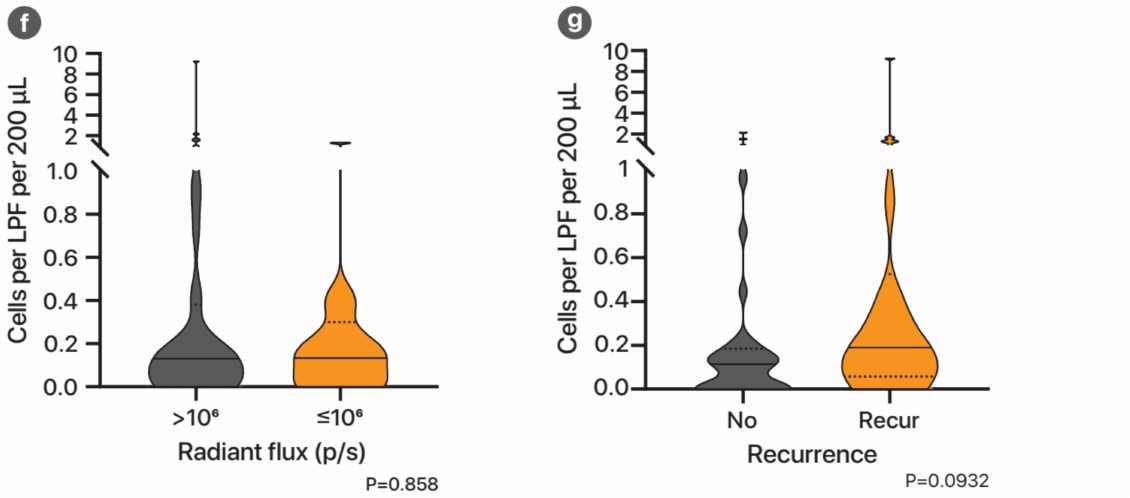
Figure 4. Effect of tumour burden and treatments on circulating tumour cells and circulating pancreatic stellate cells. ( a ) Violin plot of circulating rare cell numbers. This includes all mice, regardless of treatment group allocation. Solid transverse line represents the median. Dotted lines represent the first and third quartiles. (b ) CTC counts in animals with and without recurrence, as defined by the combination criteria. *** p < 0.001. ( c ) Receiver operator characteristic curve describing the performance of CTC counts as a test to determine recurrent disease. Different points in the curve represent different cut-offs for CTC counts. The area under the curve (AUC) represents the effectiveness of the test in discriminating recurrence. AUC values range from 0.5 (not better than chance) to 1.0 (perfect discriminatory test). ( d ) Poisson regression model of CTC counts versus treatments. This model assesses the effects of treatments on CTC counts, taking into account the last measured tumour burden (assessed by bioluminescence imaging). The full model specification is shown in Table A7. ( e ) Poisson regression model of portal vein cPSC counts versus treatments. This model assesses the effects of treatments on cPSC counts, taking into account the tumour burden at the end of the experiment (as measured by bioluminescence flux). The model specification is shown in Table A8. ( f ) Violin plots comparing cPSC counts in animals with high tumour burden versus low tumour burden at the end of the experimental period (as determined by bioluminescence imaging). This suggests that the observed higher cPSC counts in mice with recurrent disease is not due simply to higher disease burden at the time of blood sampling. ( g ) Violin plots comparing the portal vein cPSC counts for animals with and without recurrence. This demonstrates a trend for higher cPSC counts to be associated with mice with recurrent disease